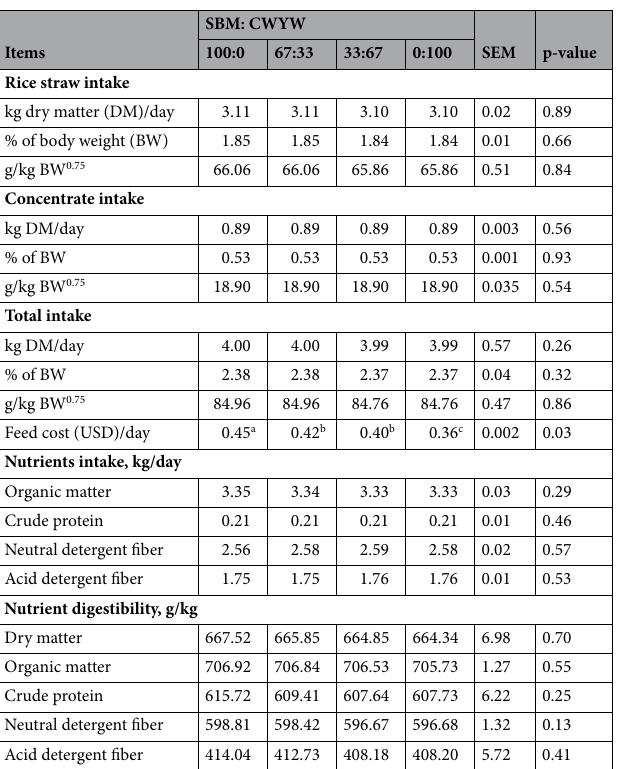
Table 2. Effect of replacing soybean meal with citric waste fermented yeast waste on feed intake and nutrient digestibility in Thai-native cattle. SEM standard error of the mean, SBM:CWYW replacing soybean meal with citric waste fermented yeast waste ratio, a,b,c Value on the same row with different superscripts differ (p < 0.05).